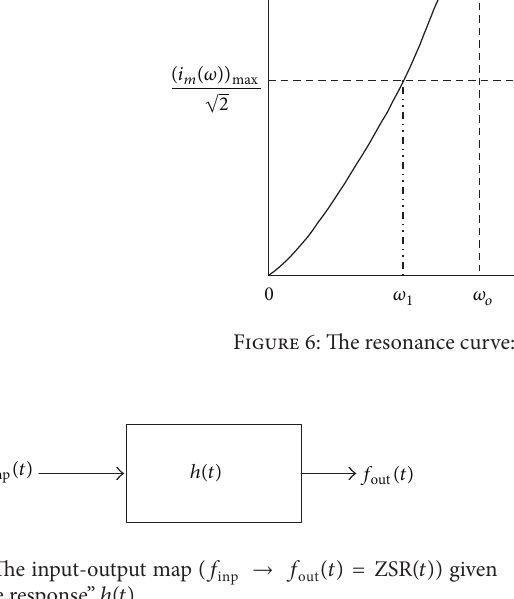
Figure 7: The input-output map ( 𝑓 by “impulse response” ℎ(𝑡) .